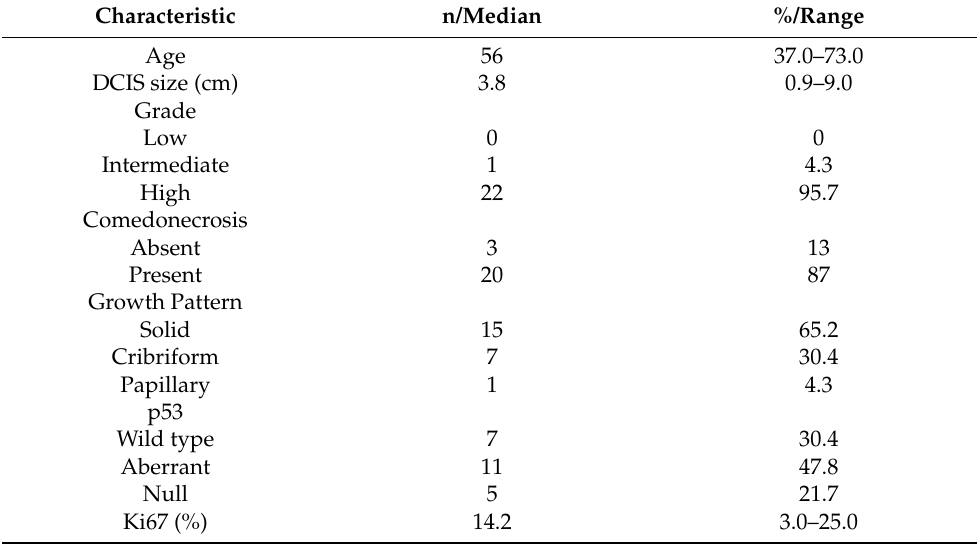
Table 1. Patient and DCIS